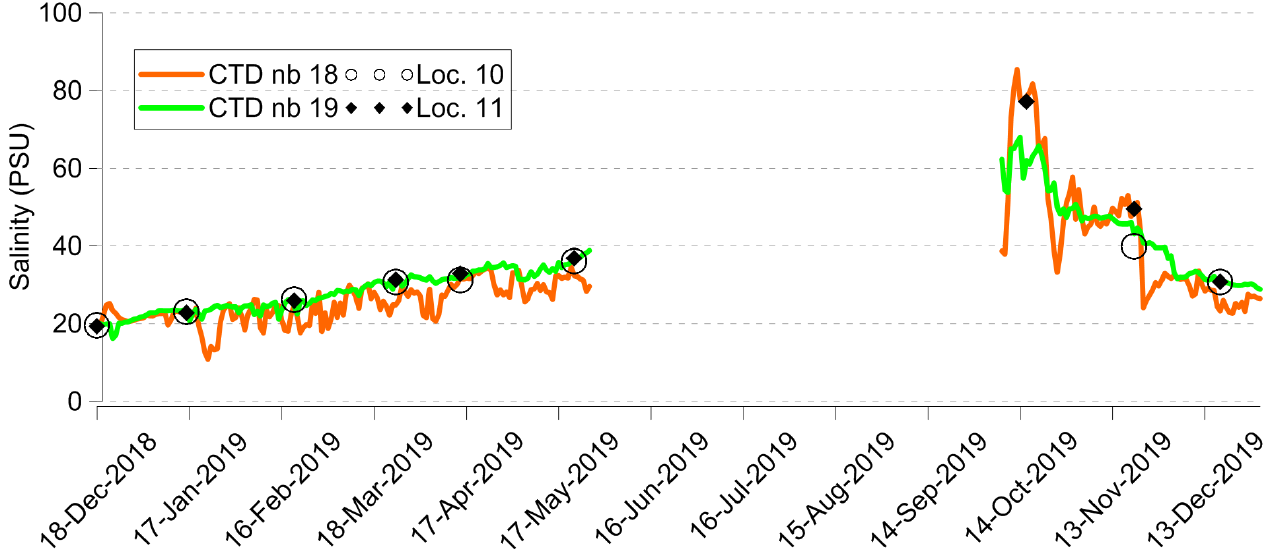
Figure 5. Daily averaged salinity measured at locations 18 and 19 (Figure 2) from 18 December 2018 to 31 December 2019. Monthly in situ salinity measurements at locations 10 and 11 are also represented. Regarding the salinity data of the two CTD probes, the absence of a line indicates missing data, due to an instrumental problem (probe clogging) or water levels too low for the conductivity sensor to remain immersed.